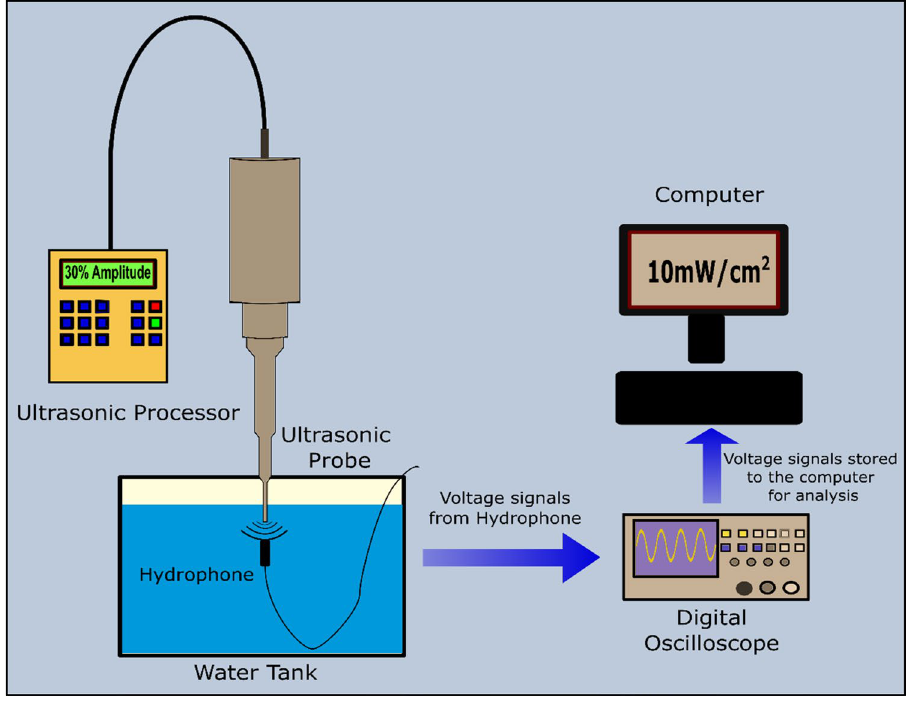
Figure 3. A schematic diagram showing the experimental setup for measuring power